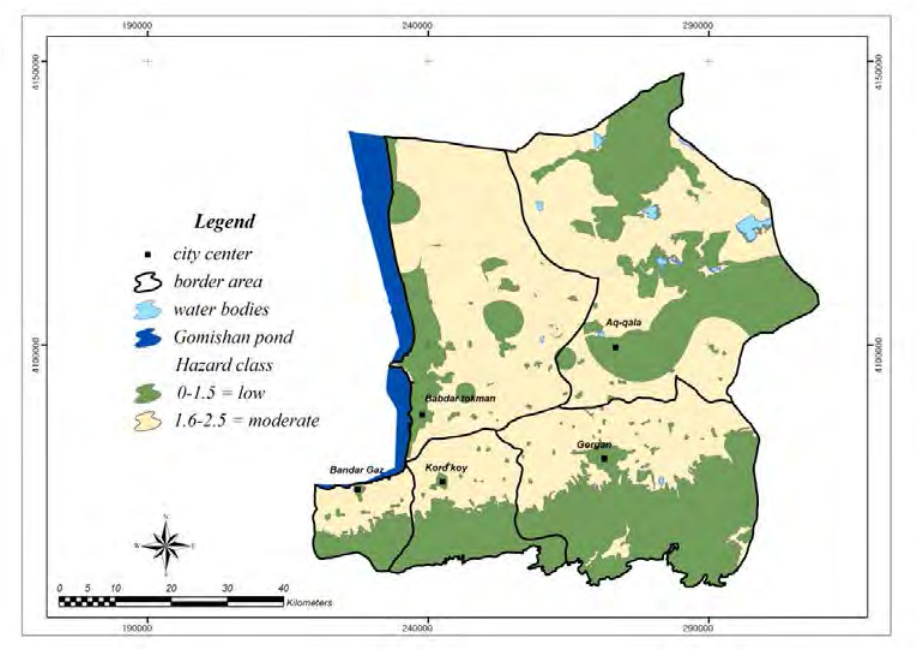
Fig. 3: Desertification hazard map of the study area Table 12: Frequency distribution of the percentage of each element at risk in the study area Qualitative range of the Element vulnerability of elements at risk